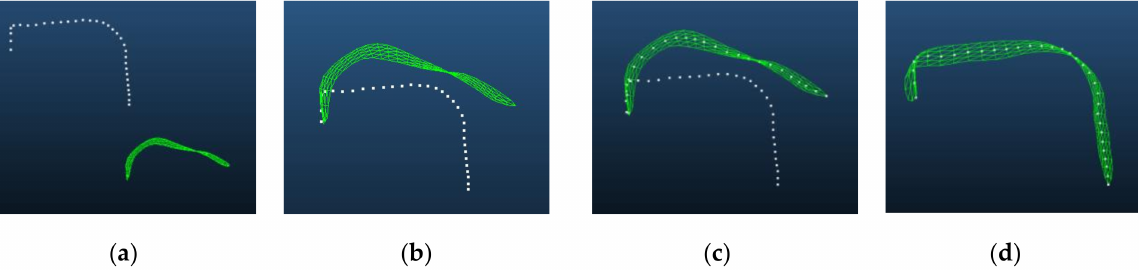
Figure 5. The vein-driven leaf mesh deformation process. ( a ) Template calling; ( b ) Scaling and translation; ( c ) Leaf vein curve resampling; ( d ) Mesh deformation based on